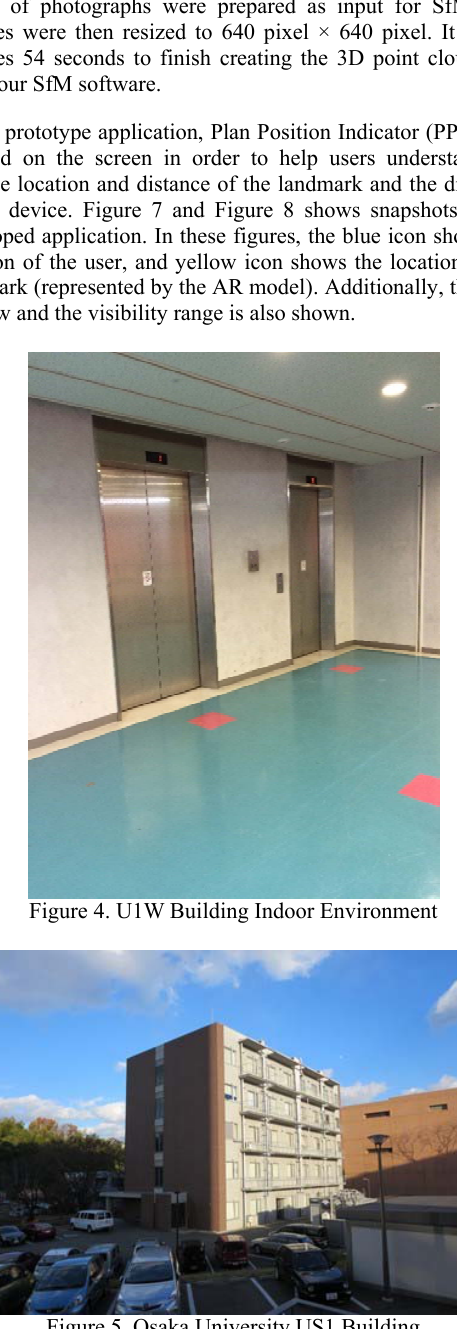
Figure 6. Location of U1W and US1